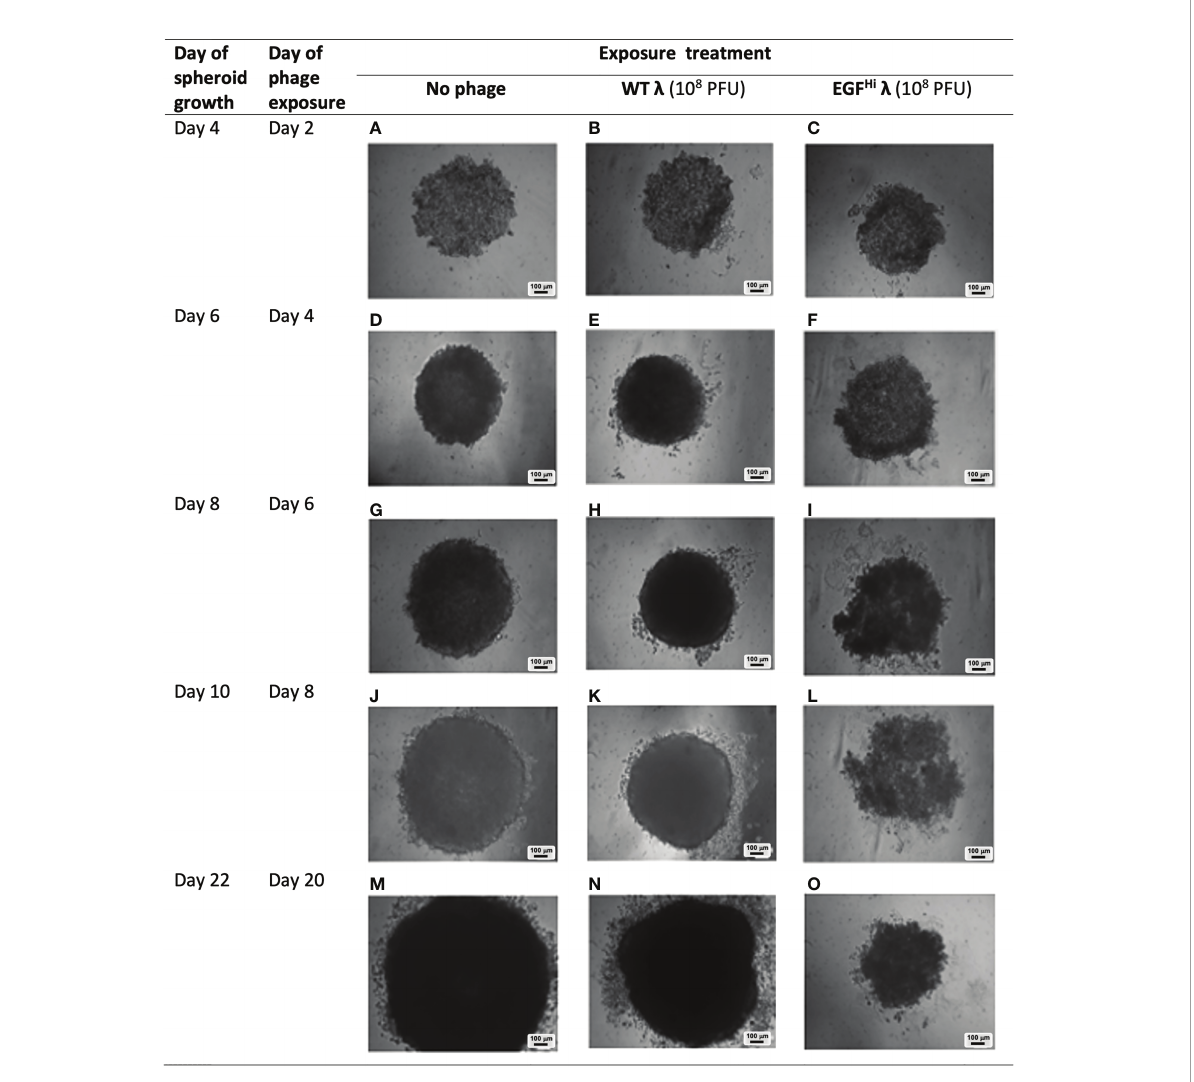
FIGURE 9 Persistence of effect of EGF-decorated phages on spheroid development. WT l (B, E, H, K, N) or EGF Hi l (C, F, I, L, O) phages (10 8 PFU) were added to partially-formed HT29 spheroids at 48 h after seeding and followed for a further 20d as shown, and compared to controls (A, D, G, J, M) . The precise morphologic fi ndings were varied over 3 independent experiments but this shows a representative example of how the EGF l phages had a persist disruptive effect on spheroid formation that was clearly evident out to d8 after phage addition and led to the ultimate formation of a signi fi cantly compromised spheroid. This was not evident with WT l , or with l phages with lower EGF decoration (EGF Lo l , not shown). Images are bright fi eld of spheroids in situ on agarose, and scale bars are